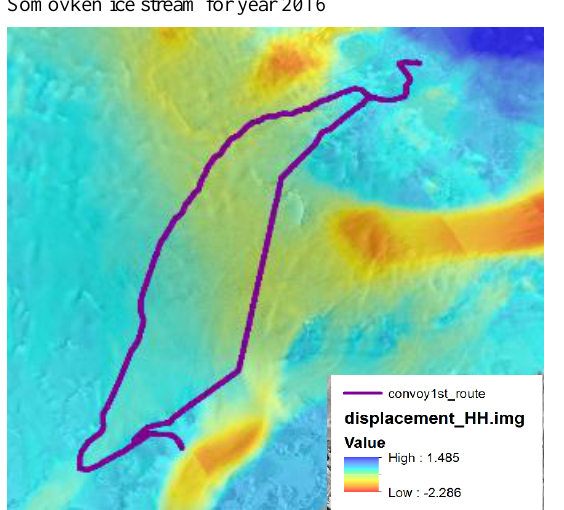
Figure 14. Ice sheet velocity using Sentinel-1 based DInSAR data for 18-30 September 2016, with field survey track.